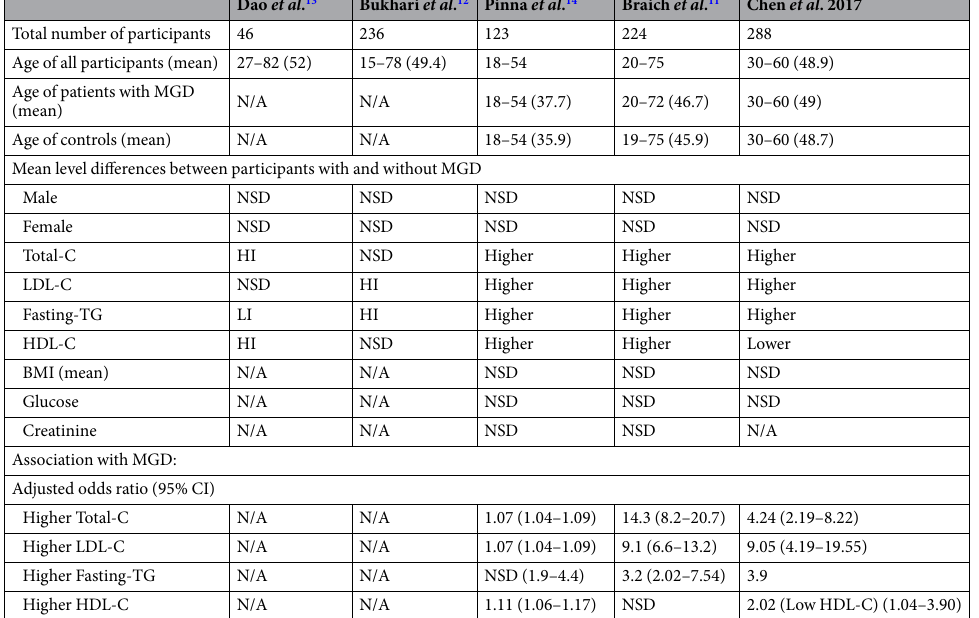
Table 5. Comparison of Key Findings between Current and Previous Studies. CI = confidence interval; HDL-C = high-density lipoprotein cholesterol; HI = higher incidence; LDL-C = low-density lipoprotein cholesterol; LI = lower incidence; MGD = meibomian gland dysfunction; N/A = not available; NSD = no significant differences; TG = triglyceride; Total-C = total